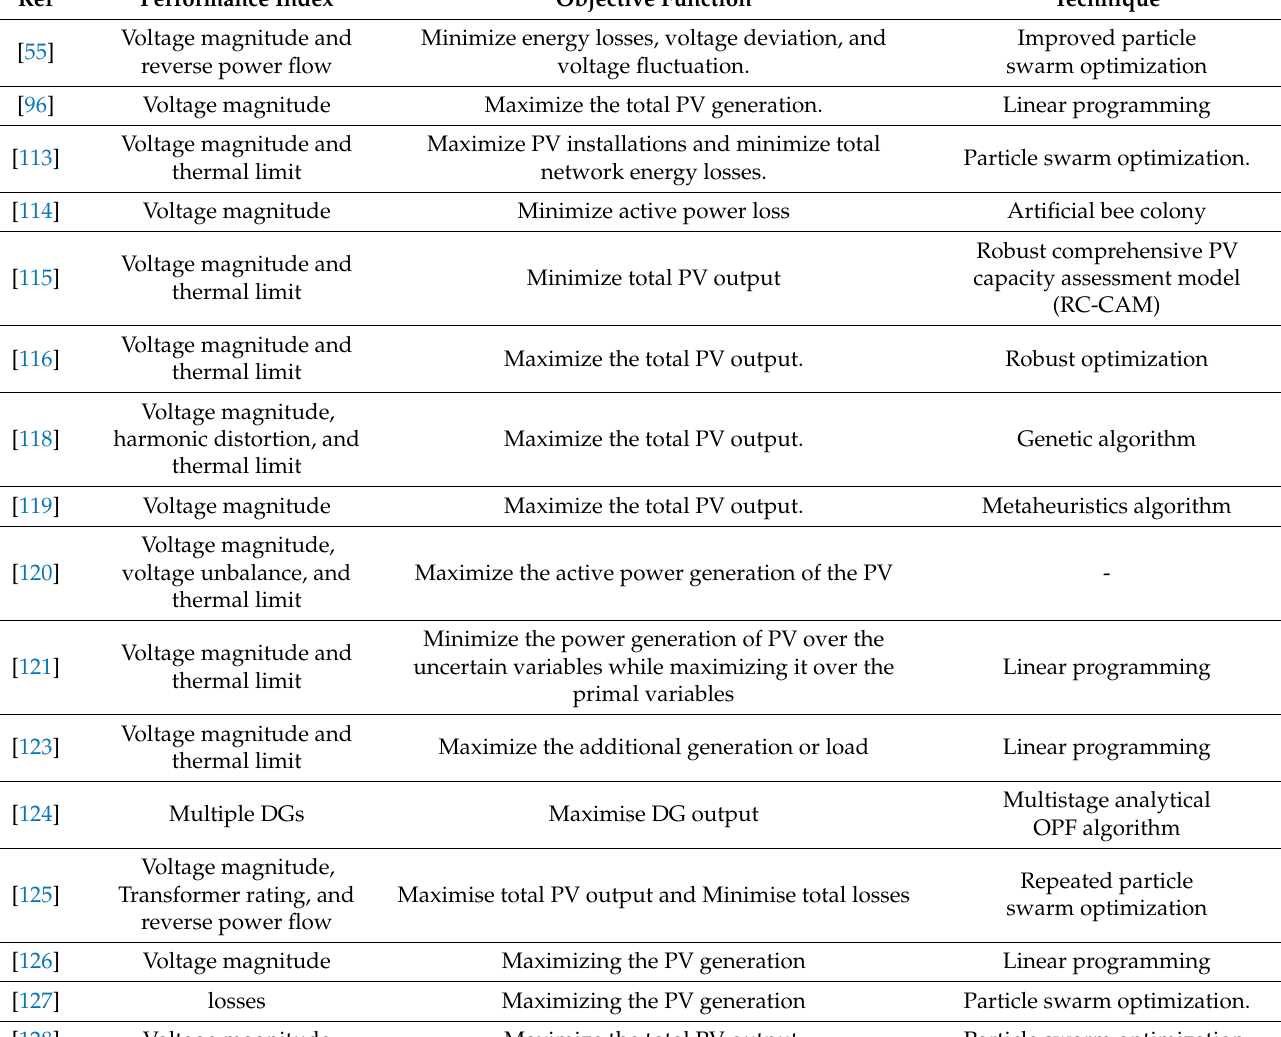
Table 5. Summary of studies that adopt the optimization-based method for PV hosting capacity